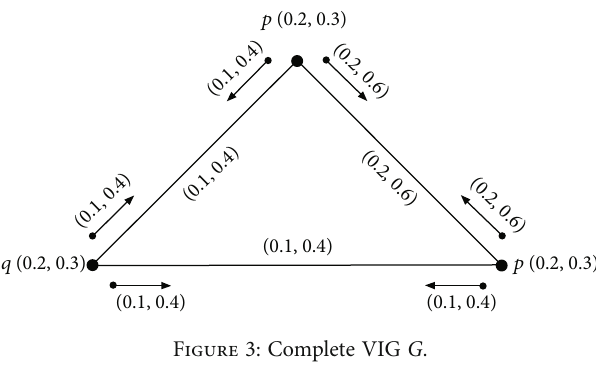
Figure 3: Complete VIG G .